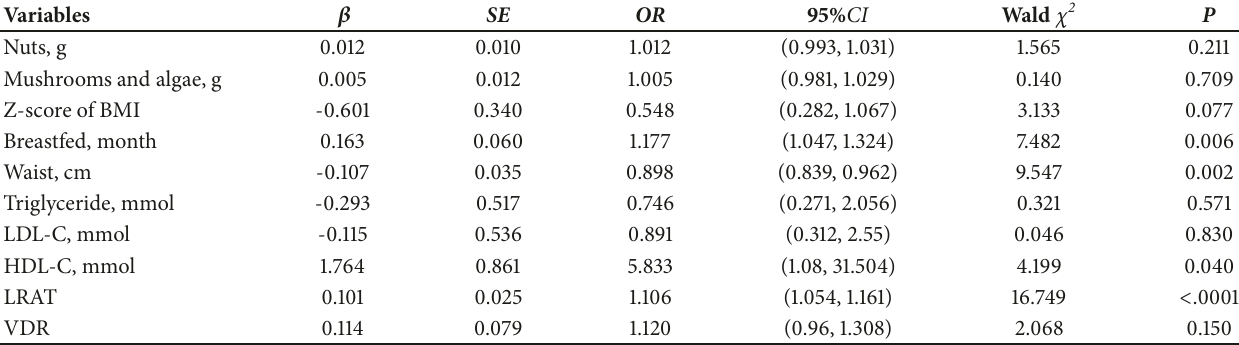
Table 2: Logistic regression model analyzed the risk factors of children with